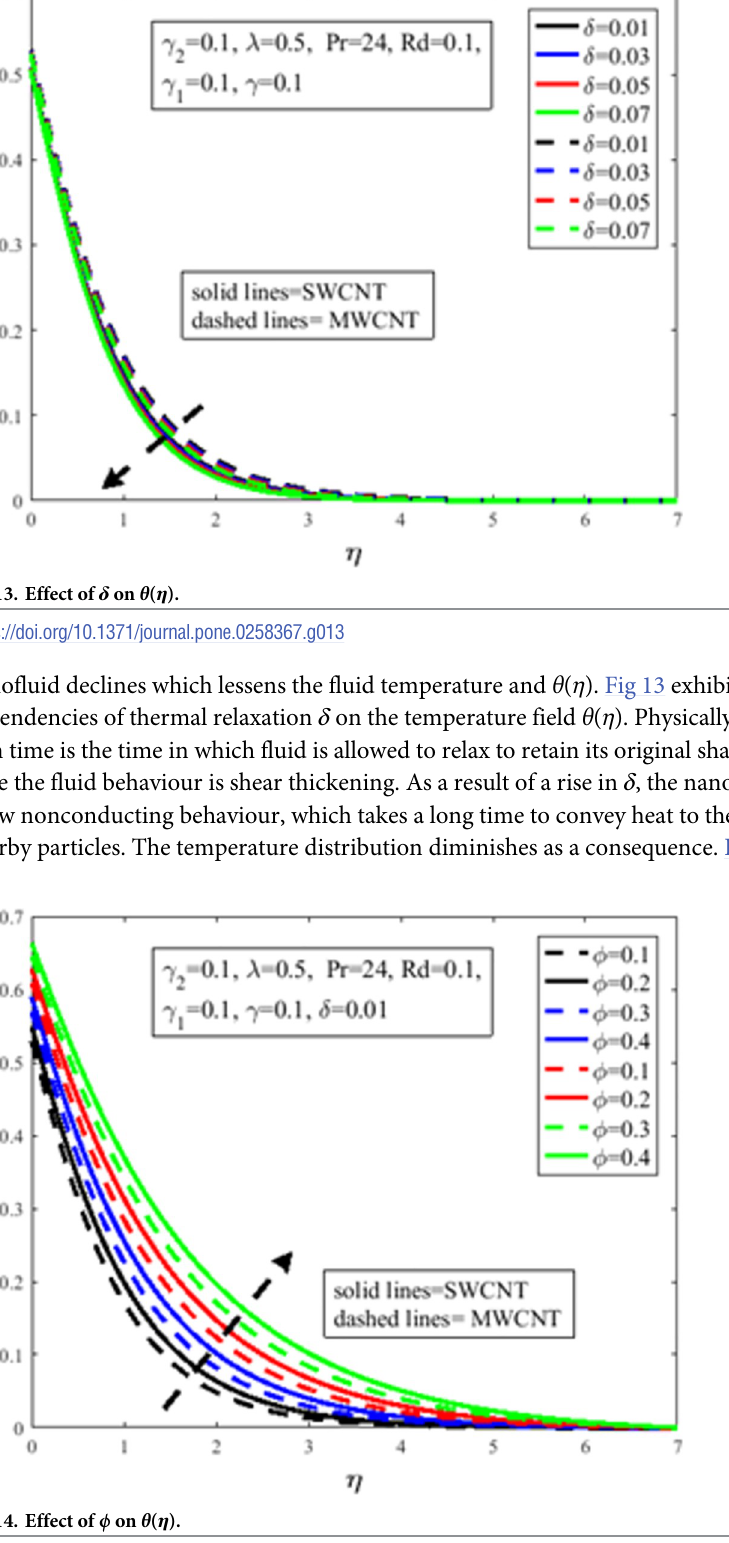
Fig 14. Effect of ϕ on θ ( η